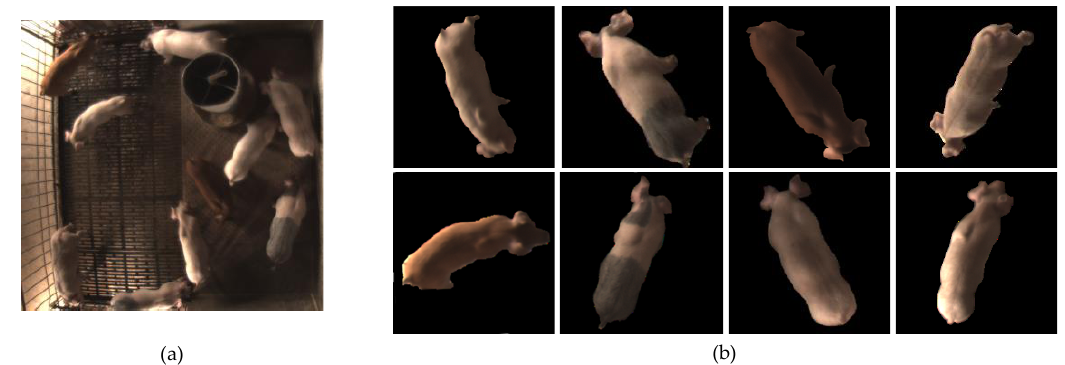
Figure 3. Video frame and samples of individual pig images after preprocessing. ( a ) One image frame of a video; ( b ) samples of individual pig images.